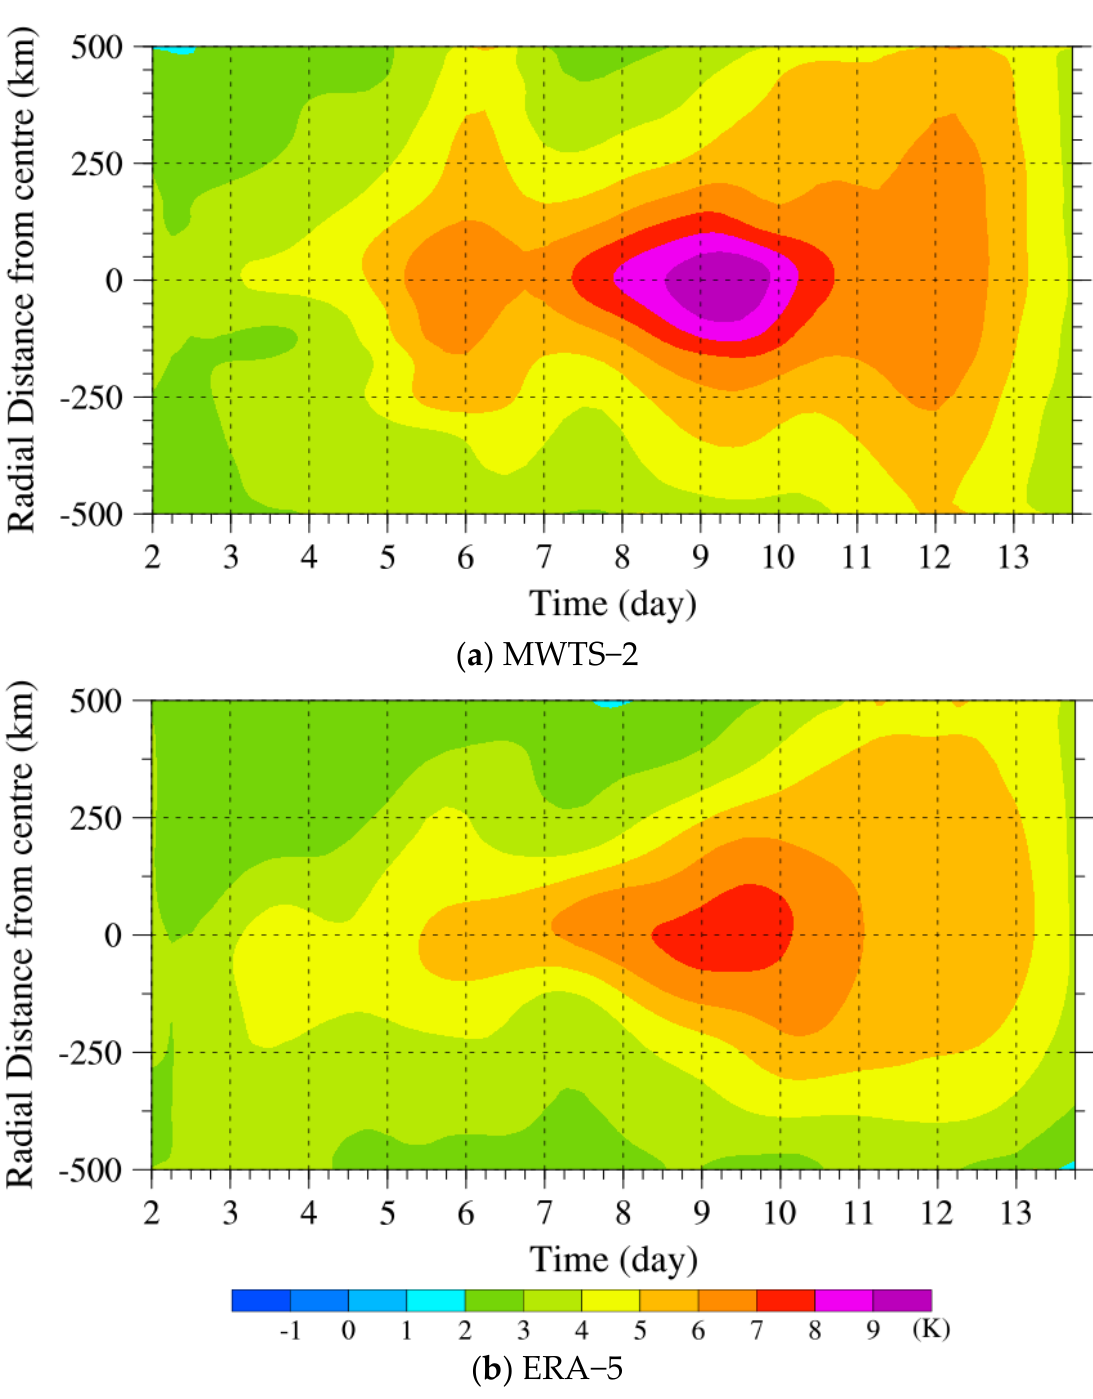
Figure 14. Temporal evolutions of the radial variation in ( a ) MWTS-2 retrieved temperature anomalies and ( b ) ERA5 temperature anomalies at 250 hPa within a 500-km radial distance along the west-east direction from the center of Typhoon Lekima from 2 to 14 August 2019.